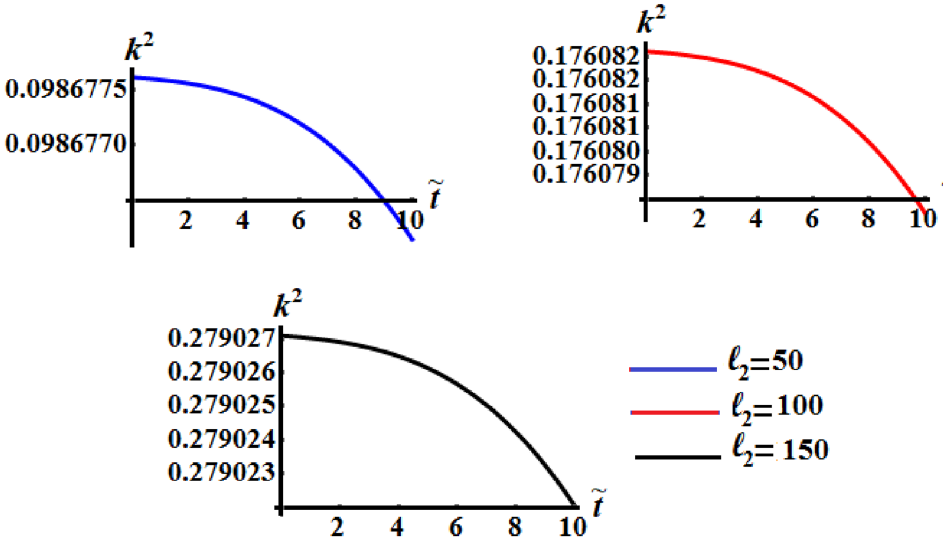
Figure 10. Exhibits the change of k 2 over time when ℓ 1 = 200 kg m 2 s − 1 and ℓ 3 = 50 kg m 2 s − 1 at ℓ